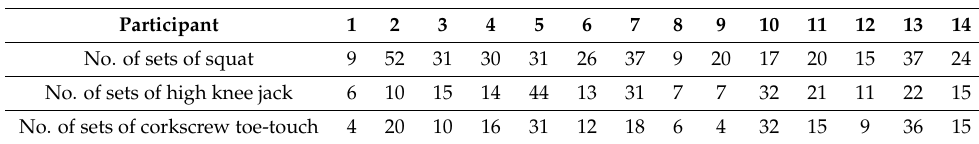
Table 3. Number of recorded exercise